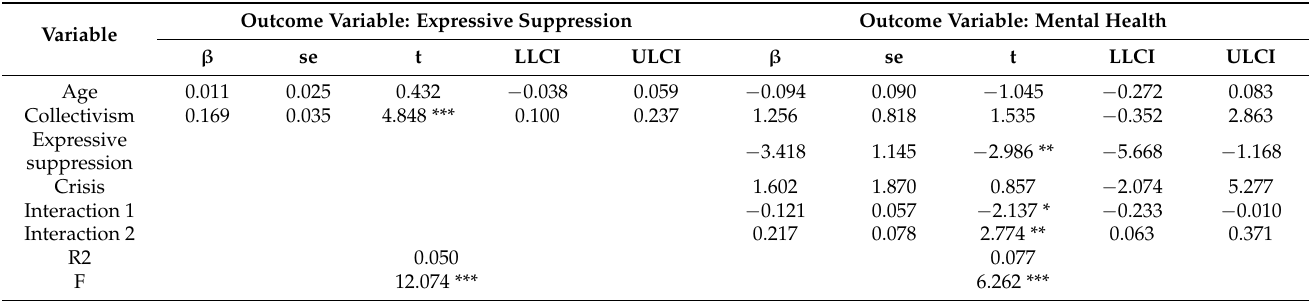
Table 2. Moderated mediating model test.